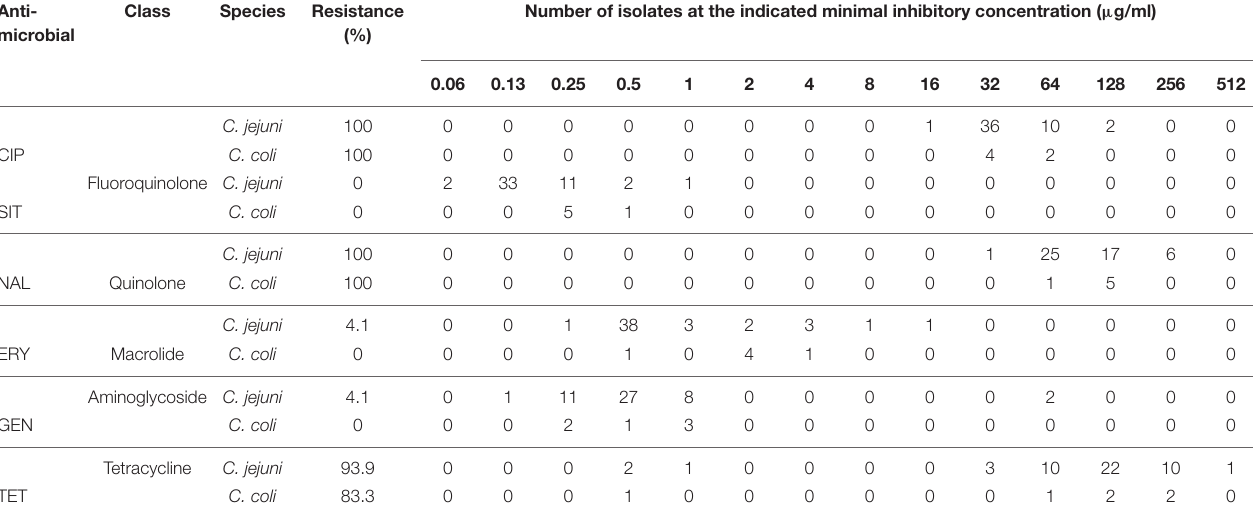
Aminoglycoside C.